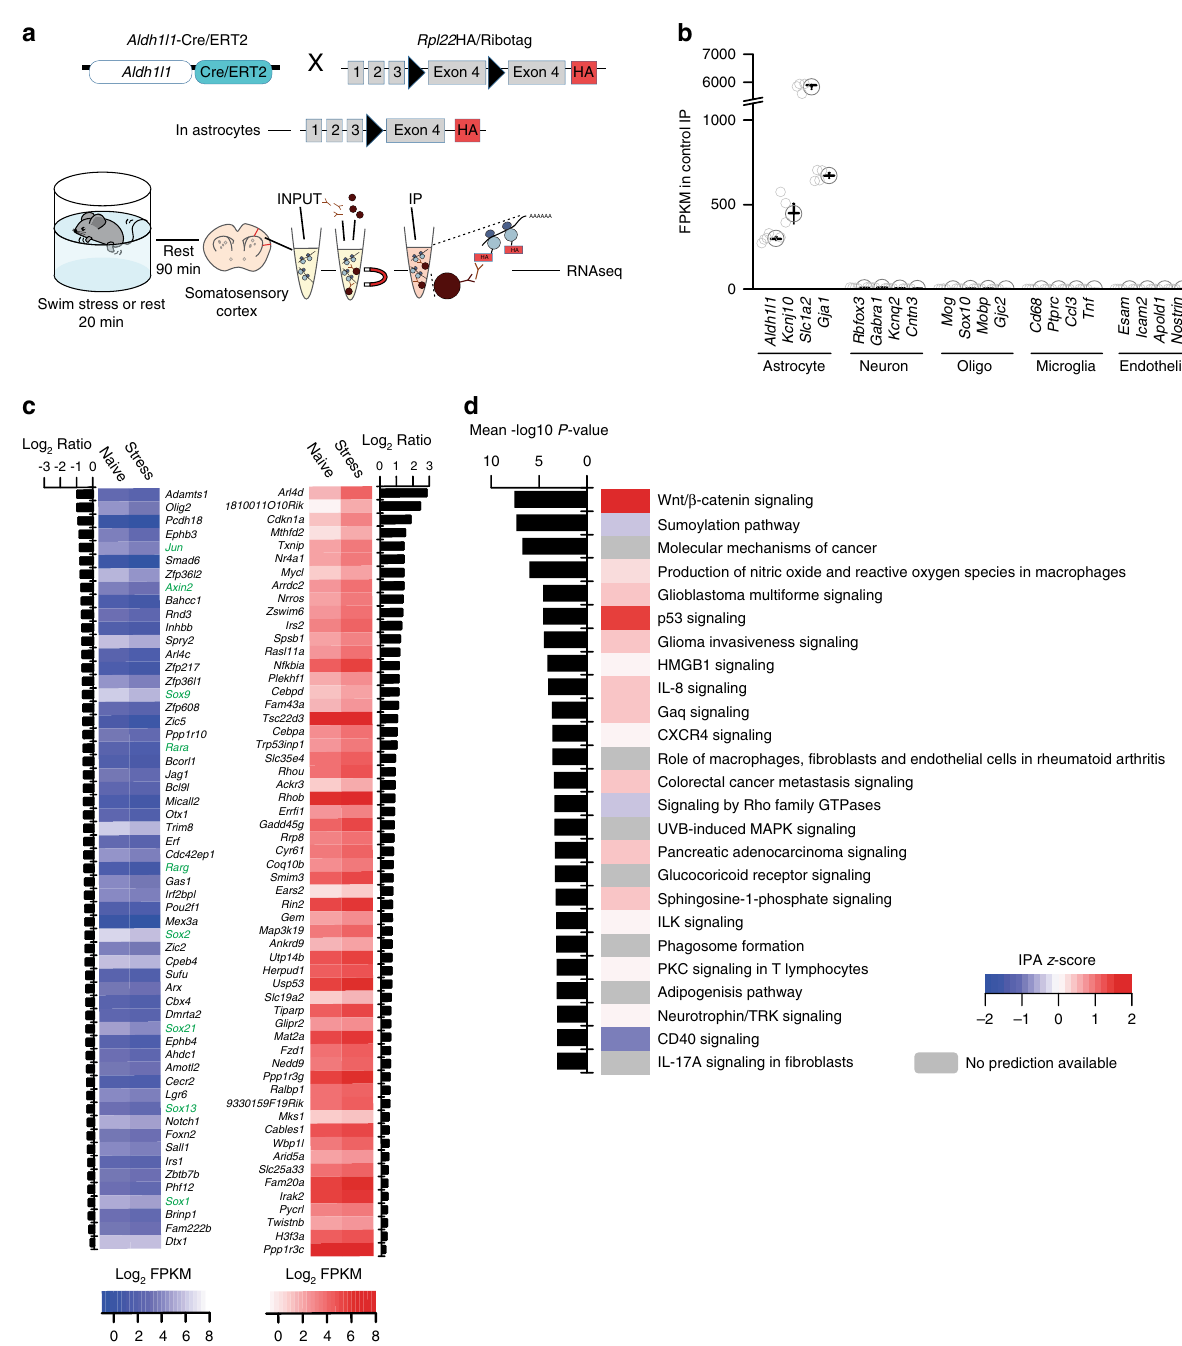
Fig. 1 Acute stress alters astrocyte genes associated with connexins and cell growth. a Upper – illustration of how the knock-in mouse line used for astrocyte RNAseq experiments was generated. Lower – illustration of experimental protocol used. INPUT indicates total RNA (not speci fi c to astrocytes). IP indicates immunoprecipitate, whereby astrocyte ribosomes were isolated. b Validation of RNAseq speci fi city using Aldh1l1 -cre/ERT2 X RiboTag mouse, comparing the expression of several astrocyte-speci fi c with non-speci fi c (i.e. non-astrocytic) genes in our immunoprecipitated (IP) sample. Error bars – mean±s.e.m. c Heat map of gene expression changes following stress (FDR<0.05). Upregulated genes in red. Downregulated genes in blue. Green denotes genes involved in Wnt/ B-catenin signaling pathway. d Top 25 IPA (Ingenuity Pathway Analysis, Qiagen) Canonical Pathways modi fi ed by a single bout of acute stress. The IPA z -score indicates the predicted inhibition, in blue, or activation, in red, of the pathways in accordance with the gene expression